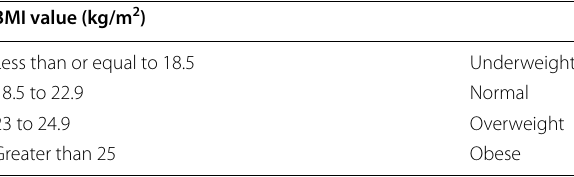
Table 1 Standards of WHO for Asia–Pacific region [3] BMI value (kg/m 2